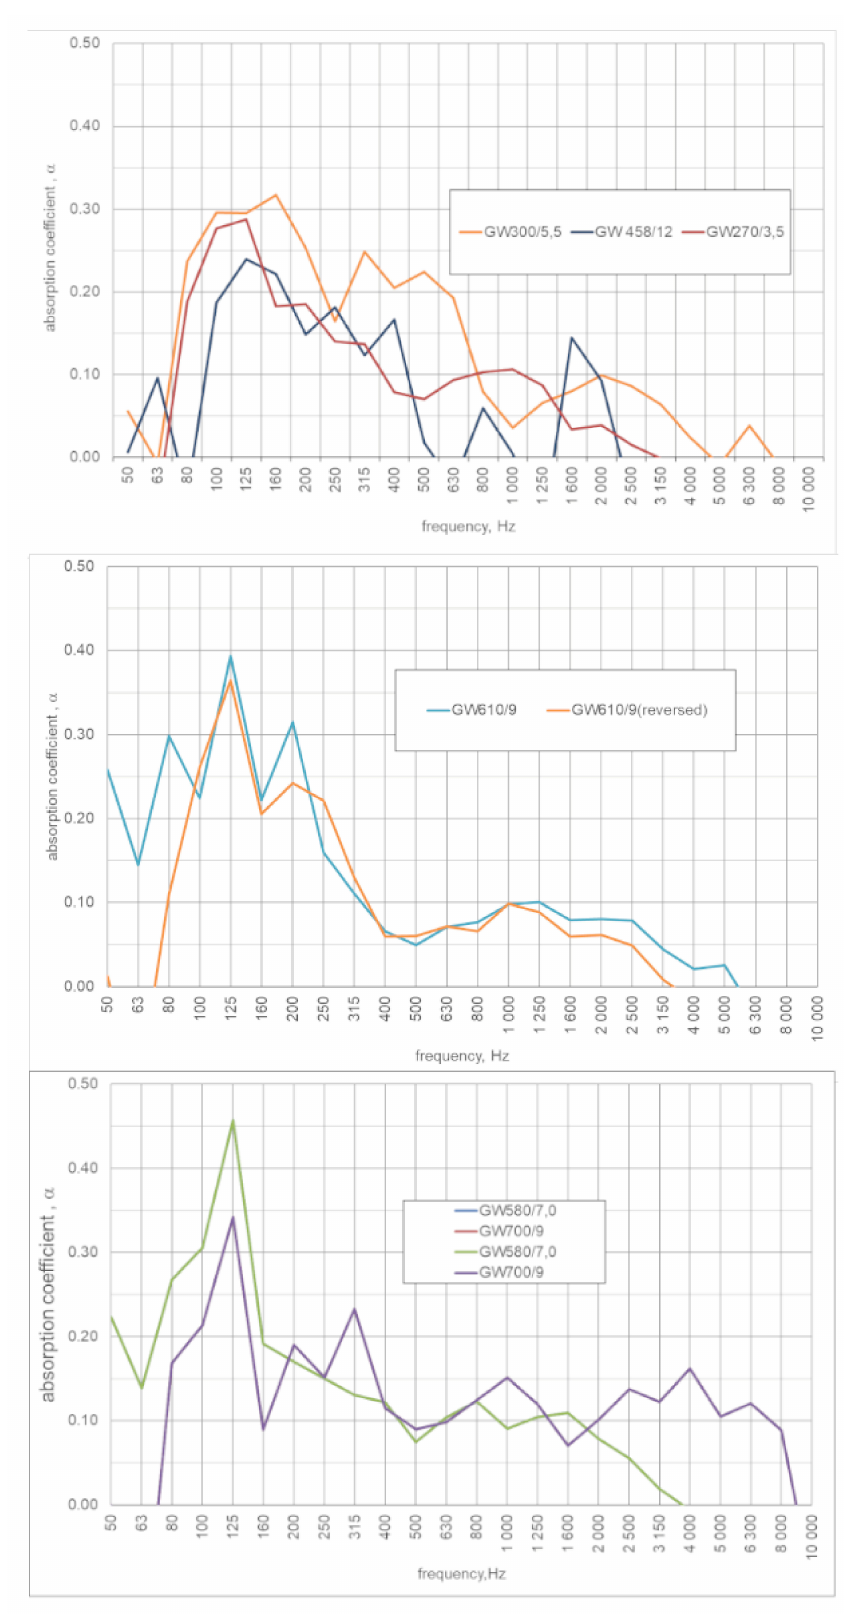
Figure 9. The measured absorption coefficient of studied PVC